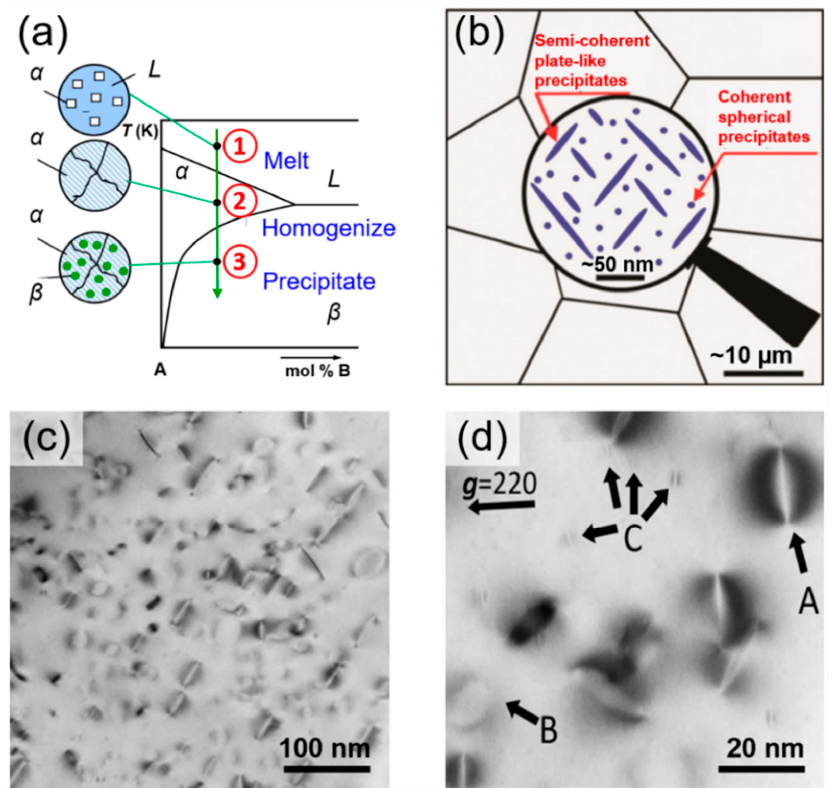
Figure 1. ( a ) Precipitates naturally form when the melt cools from the α -phase region in a binary phase diagram. ( b ) Micro- and nanoscale schematics of a nanostructured bulk material containing various types of precipitates. ( c ) Low- and ( d ) high-magnification bright-field transmission electron microscopy (TEM) images of nanostructured bulk Si, showing the homogeneous distribution of nanoscale precipitates in the Si matrix. Contrast shows strain arising from the precipitates. In ( d ), the arrows A and B indicate plate-like precipitates along (high contrast) and perpendicular (lesser contrast) to the electron beam, respectively. The arrow C indicates very small (the average diameter < 5 nm) precipitates with a butterfly-like shade. Reproduced with permission from Ref. [26]. Copyright 2009, the Royal Society of Chemistry.